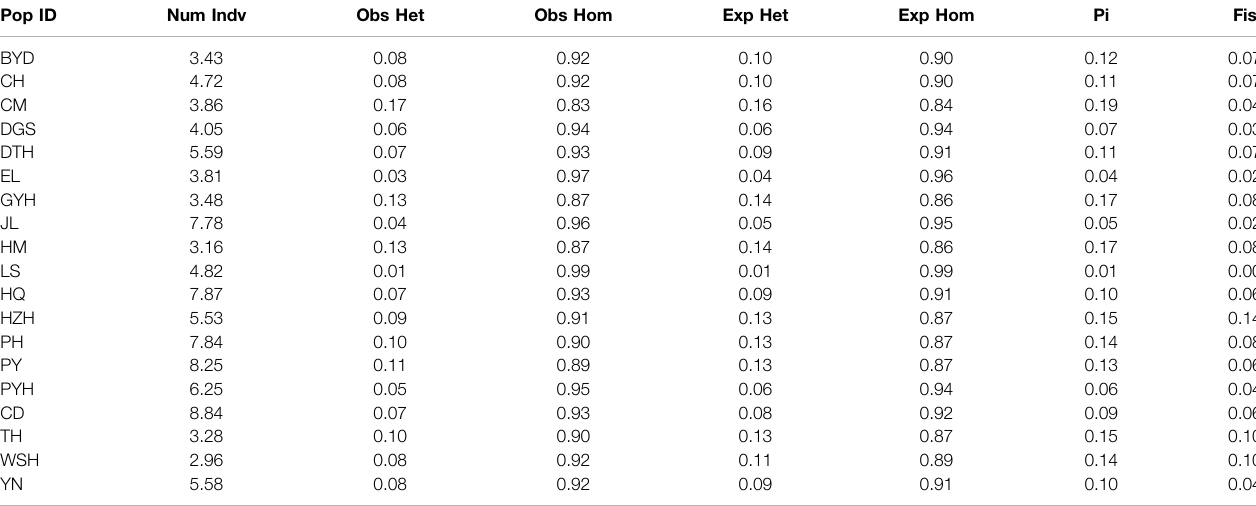
TABLE 1 | The genetic diversity of the M. albus in 19 populations based on the high consistency population single nucleotide polymorphisms (SNPs). Pop ID Num Indv Obs Het Obs Hom Exp Het Exp Hom Pi Fis BYD